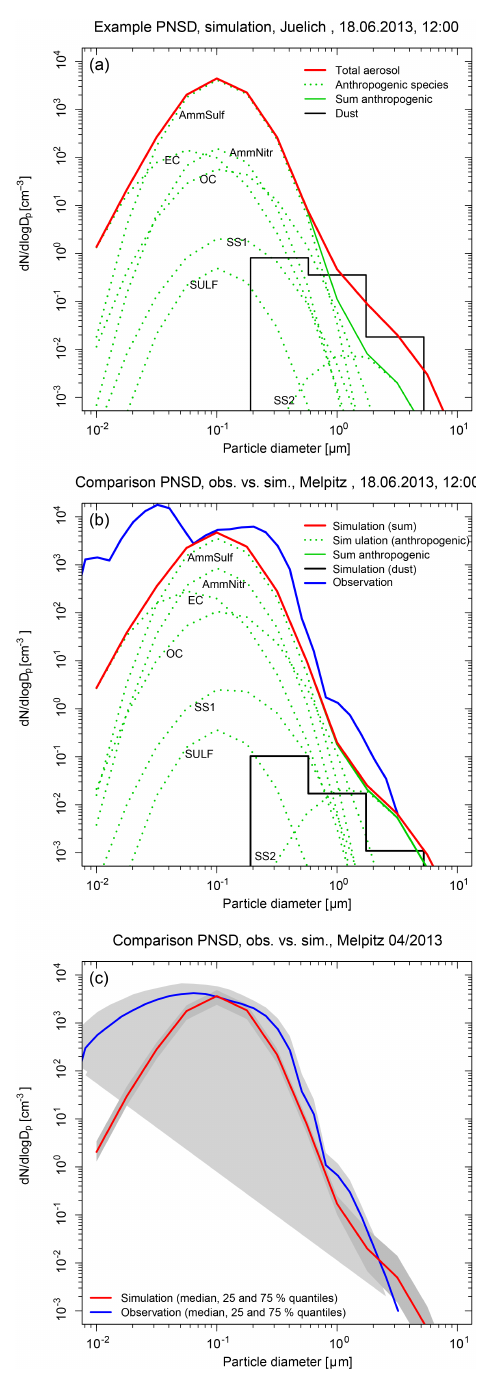
Figure 3. Aerosol particle number size distribution for 18 June 2013 at the sites Jülich (a) and Melpitz (b) , and for the month April 2013 at Melpitz (c) . The red lines mark the resulting simulated aerosol size distributions for the sum of the individual species (dotted green lines). Black lines represent modelled number size distribution of dust transported from the Sahara desert to the sites Jülich and Mel- pitz